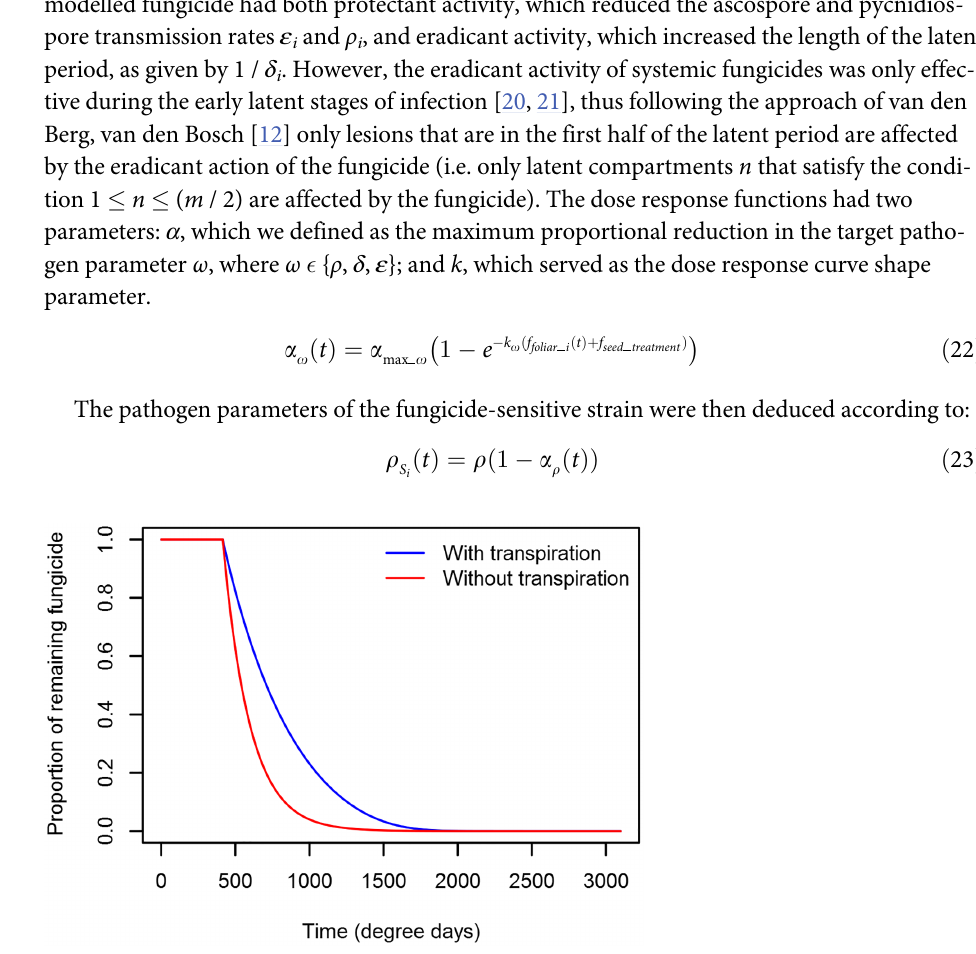
Fig 5. Seed treatment fungicide depletion for the constant versus transpiration-based seed treatment uptake model. Both models were parameterized such that 99.99% of the fungicide has been depleted from the seed at the time that leaf layer 5 is